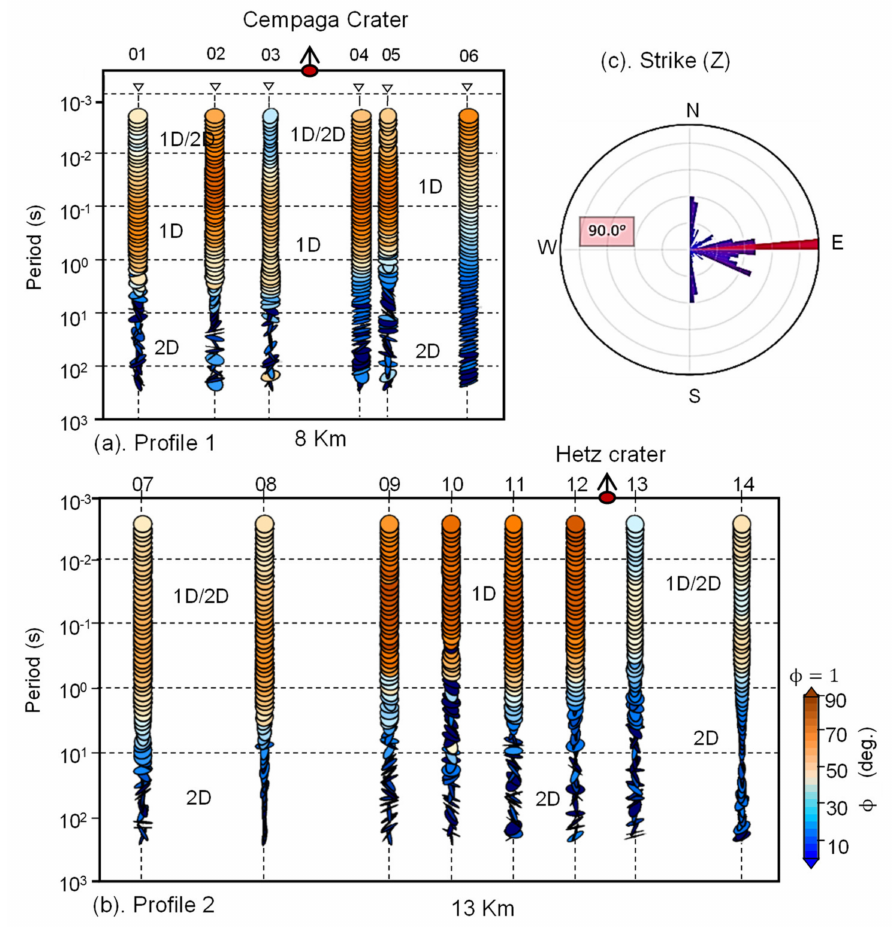
Figure 4. Pseudo-section showing the phase ellipses and minimum phase of the MT profile. The blue colours represent phase minimums below 45 ◦ , while the red colours represent phase minimums above 45 ◦ . ( a ) Profile 1 intersecting the Cempaga crater, ( b ) Profile 2 crossing the Heutsz crater, and ( c ) preferential strikes estimated from the Z -invariants, the phase tensor azimuth, and the tipper strike plotted at NW–SE (90 ◦ azimuth) from the phase